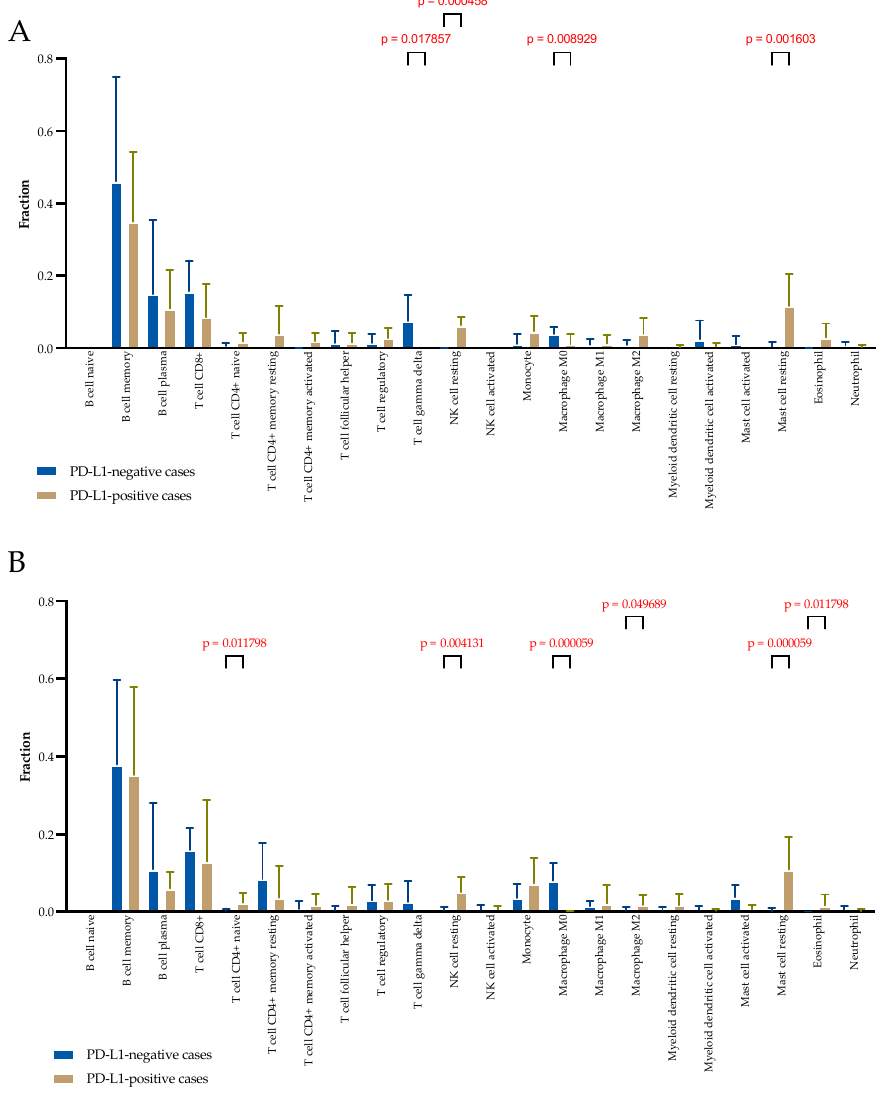
Figure 3. Comparison of the TME composition in stromal-only spots ( A ) and mixed spots ( B ) in the PD-L1-positive cases and PD-L1-negative cases using CIBERSORT analyses.